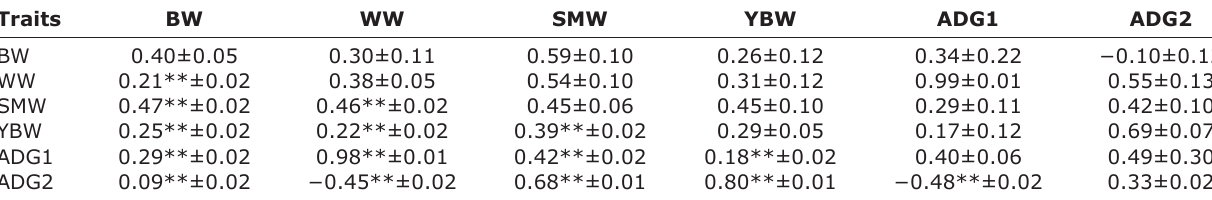
Table-3: Estimates of heritability (diagonal), genetic (above diagonal) and phenotypic (below diagonal) correlations along with standard errors among growth traits.